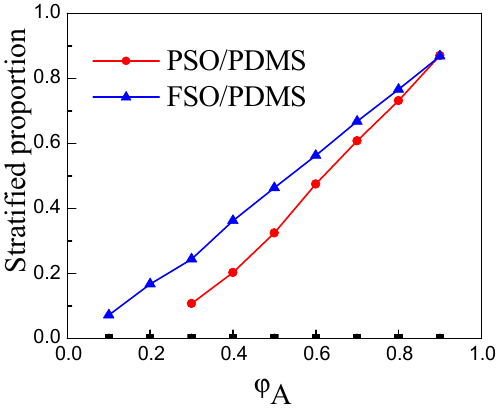
Figure 6. Concentration of silicone oil and stratified proportion.